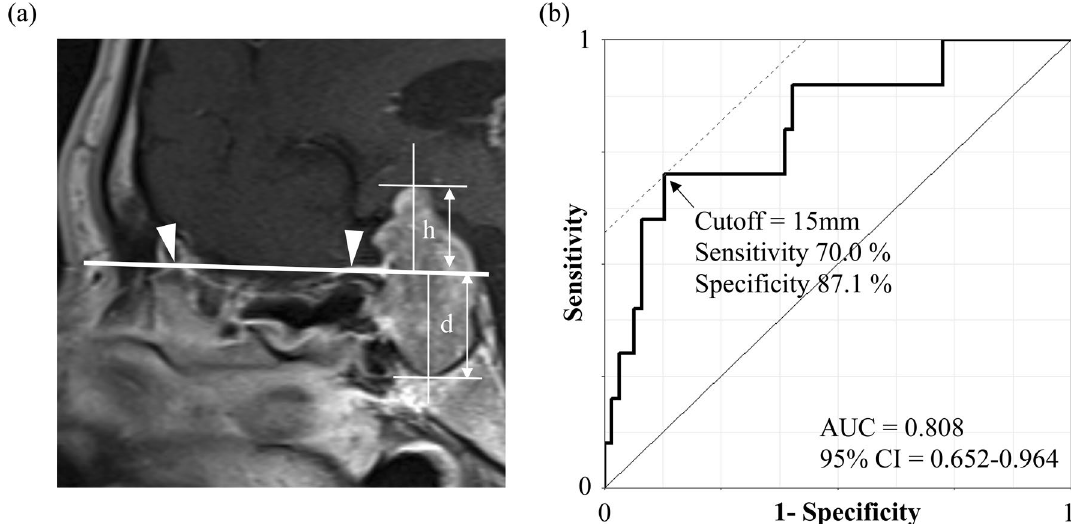
Figure 3. ( a ) Morphometric measurement of tumor height (h) and depth (d) from the planum sphenoidale and ( b ) receiver operating characteristic (ROC) curve analysis of tumor height from the planum sphenoidale for predicting permanent central diabetes insipidus. ( a ) Tumor height (h) is defined as the vertical distance from the conceptual line (white solid line) [drawn from the cristae galli (white arrowhead, left) to the planum sphenoidale (white arrowhead, right)] to the highest point of the tumor. ( b ) Area under the curve (AUC) for tumor height from the planum sphenoidale was 0.808 (95% confidence interval = 0.652–0.964). The point indicated by the arrow is the cutoff point maximizing the Youden index, which was 15 mm.